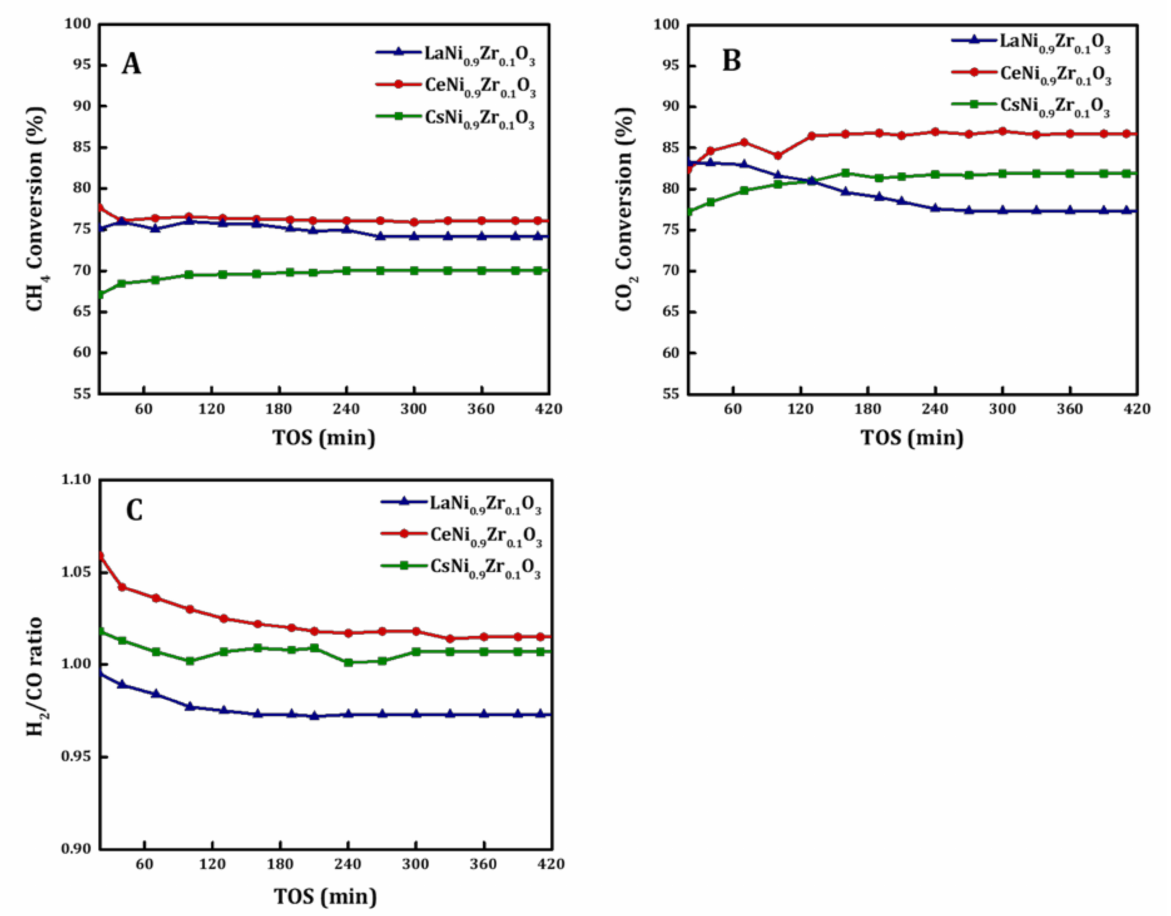
Figure 11. ( A ) CH 4 conversion; ( B ) CO 2 conversion; ( C ) H 2 /CO ratio of catalyst MNi 0.9 Zr 0.1 O 3 (M = La, Ce and Cs) at 1073 K, 1 Atmosphere and GHSV = 42 L/(h ·